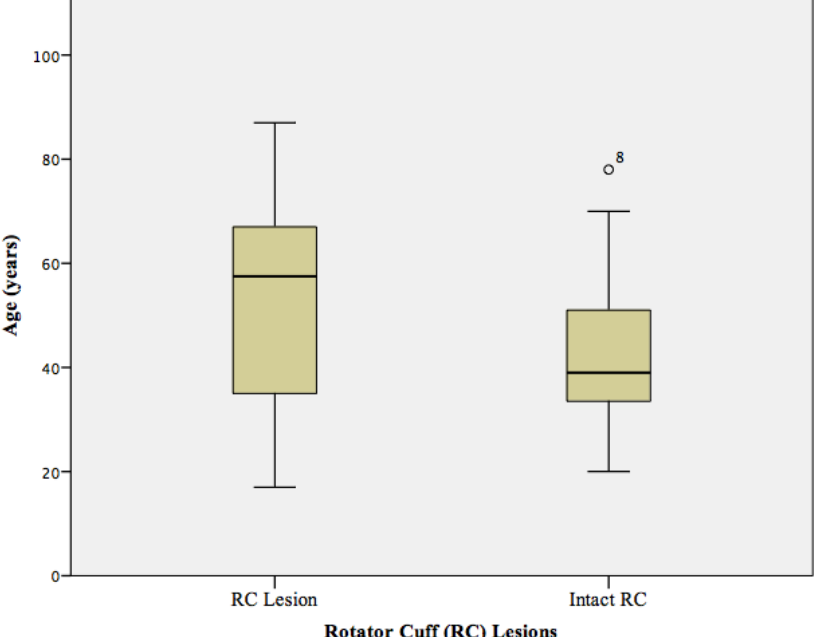
Figure 5. Mean age of patients who showed a lesion of the rotator cuff which was 54 ± 19 years and was not significantly higher compared to the patients without a lesion of the rotator cuff (mean age 43 ± 17 years, p = 0.29).